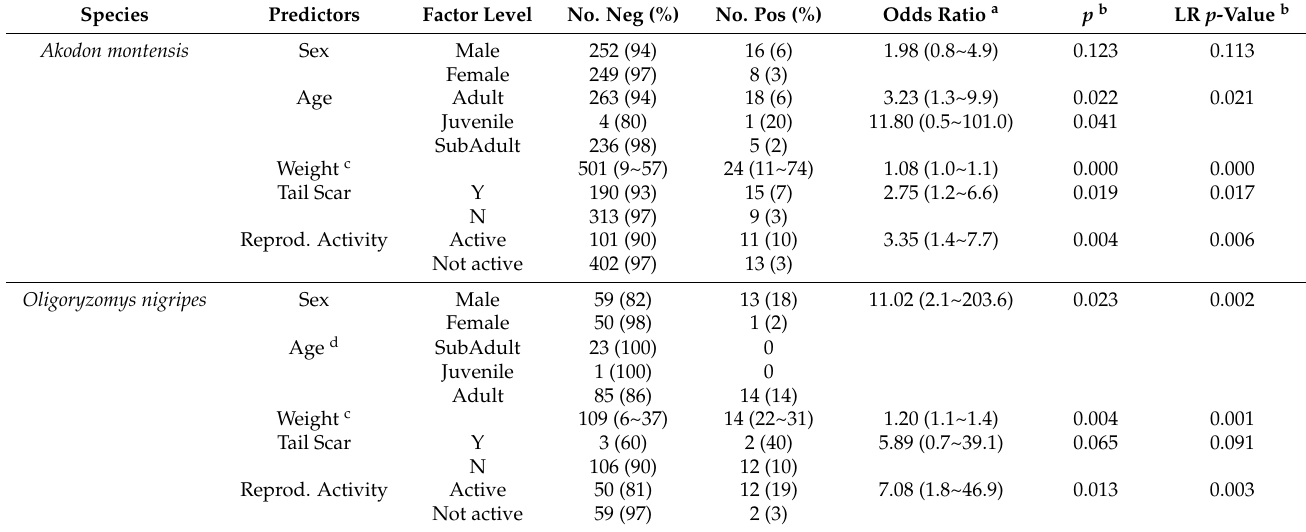
Table 3. Univariate tests of statistical association between the presence of hantavirus-reactive antibodies and rodent characteristics for two species of sigmodontine